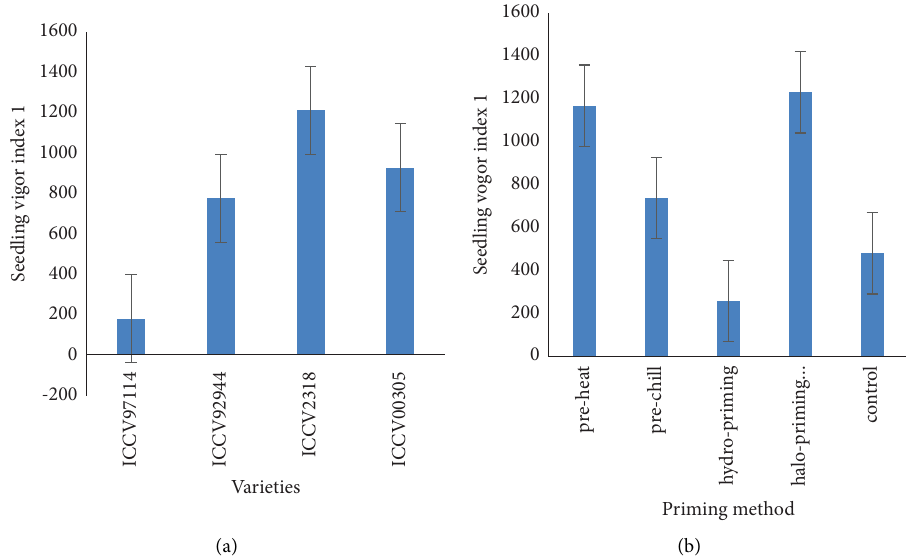
Figure 5: Efect of variety and priming method on seedling vigor index 1 of chickpea. Vertical bars represent standard error bars of